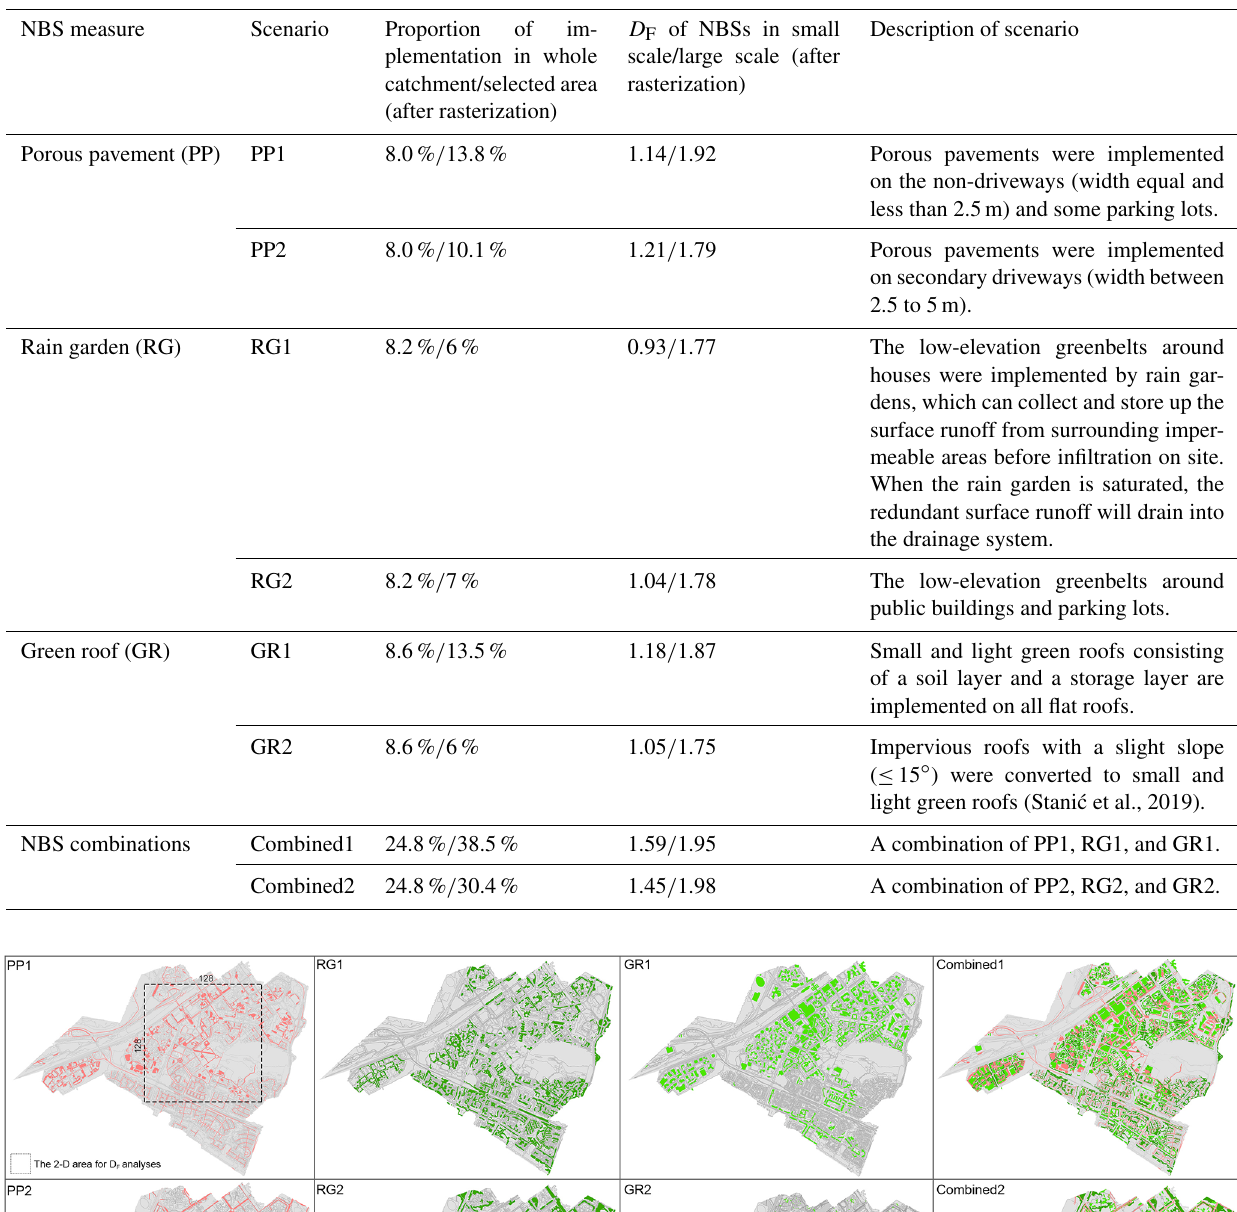
Table 4. The details of simulation of the NBS scenarios.